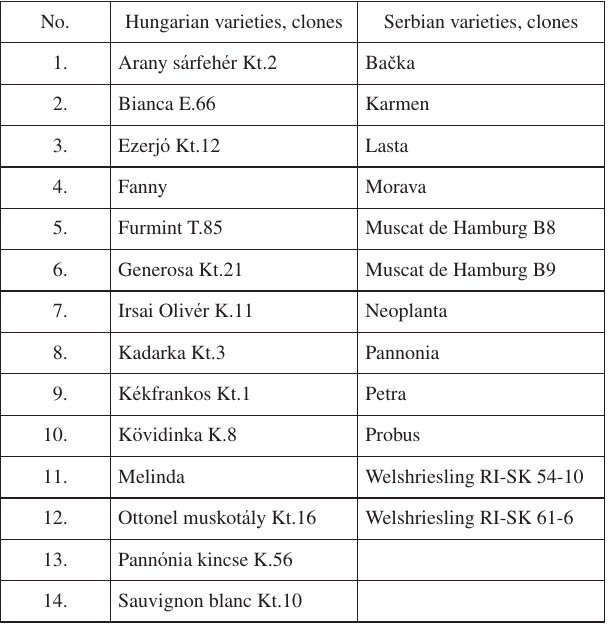
Table 1. The list of grapevine varieties (clones) involved in the pathogen-freeing program